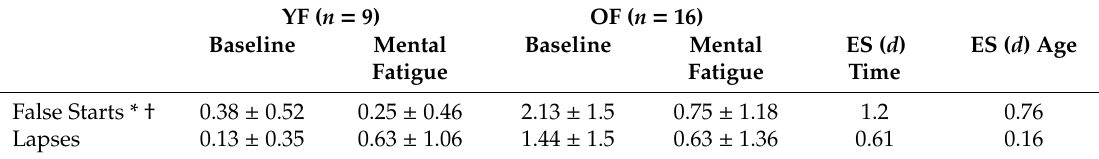
Table 3. False starts and lapses during the